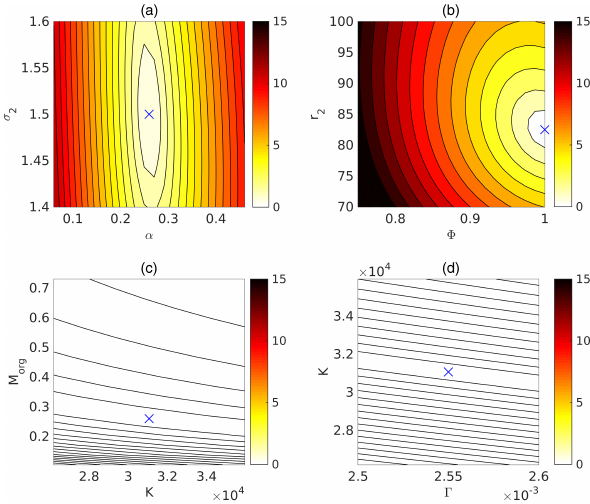
Figure 8. Response surfaces for a p w σ f in the marine average en- vironment. Blue crosses indicate the true parameter values θ true used to calculate the calibration data. The colour scale represents the value of the OF calculated for the modelled spectra against the calibration data for parameter values across the uncertainty ranges (Table